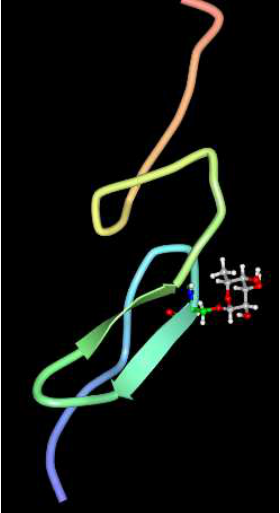
Fig. 3 Typical Fuc modification in EGF-like domain (PDBID: 1FFM powered by protein workshop) (Kao et al., 1999). Ser-60 on the edge of b -strand structure was modified by